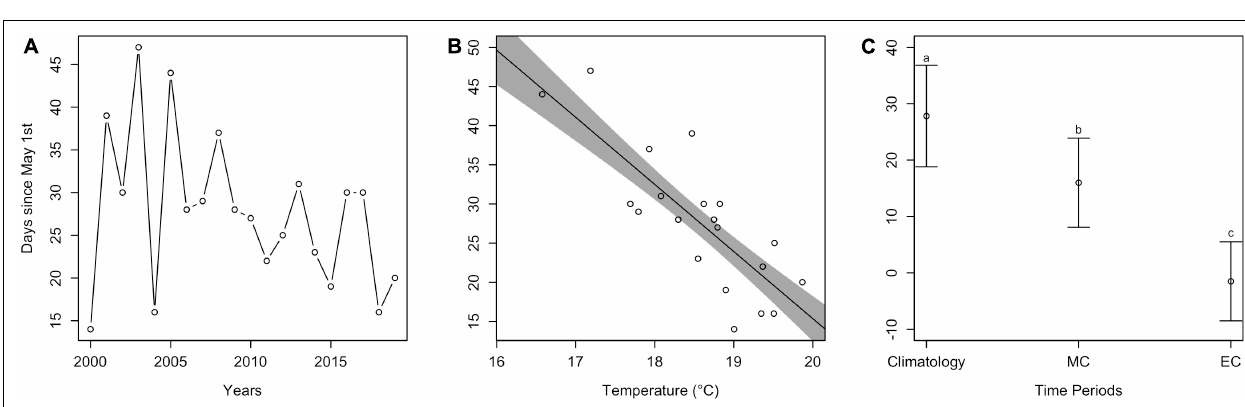
FIGURE 4 | Estimated arrival plots. (A) Estimated arrival time of cobia each year from 2000 to 2019. (B) The dots represent estimated cobia arrival times over mean May temperatures in Chesapeake Bay, while the line and shaded region represent model output and uncertainty. (C) Mean estimated cobia arrival time among climatology (i.e., contemporary), mid-century (MC), and end-of-century (EC) time periods. Different lower case letters indicate a statistical difference between time